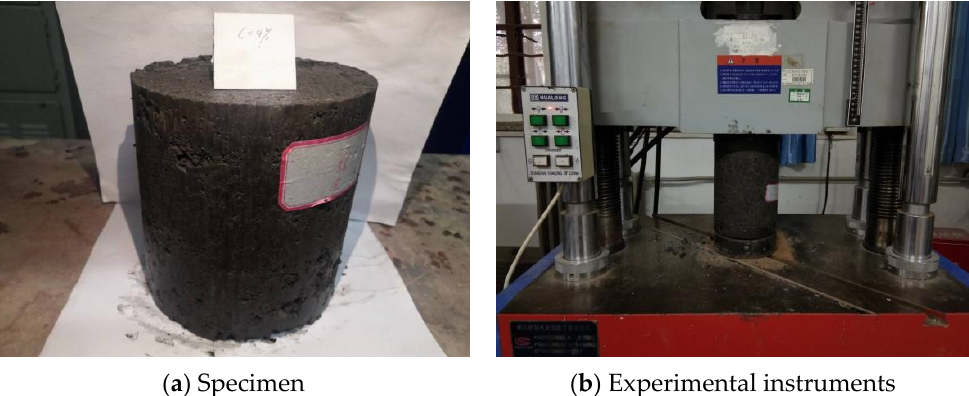
Figure 8. Unconfined compressive strength test.